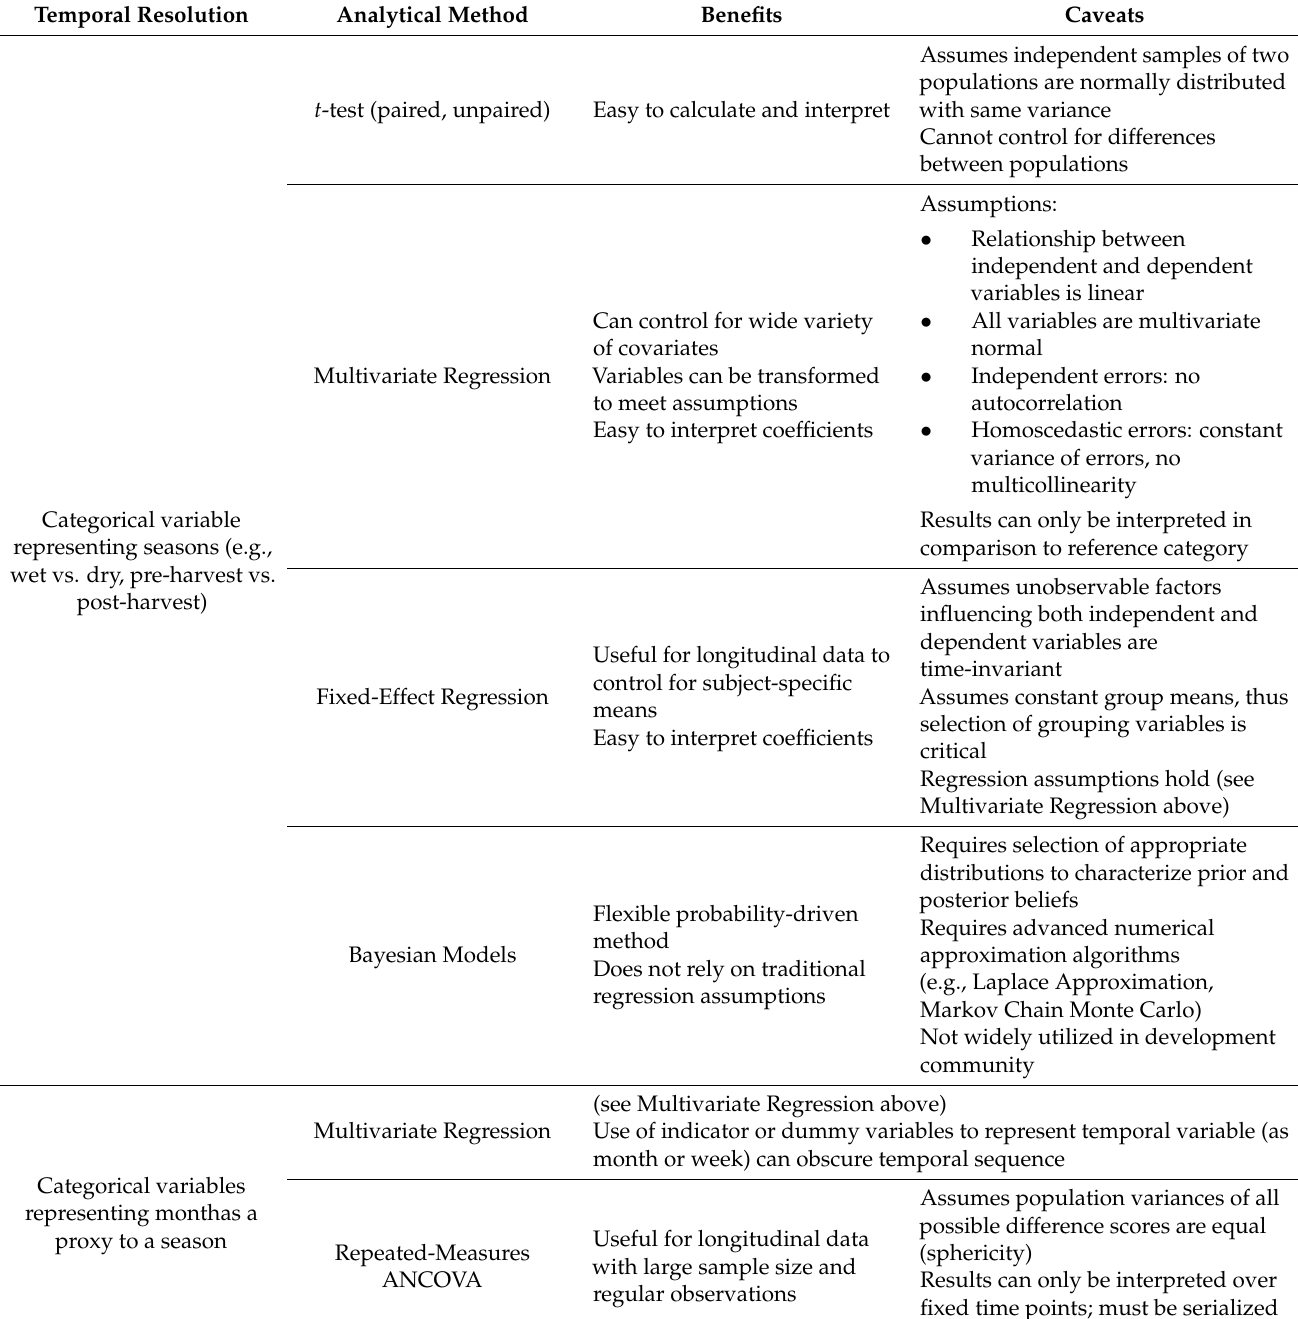
Table 2. Summary of temporal resolution, analytical methods, and their respective benefits and caveats in analyzing nutrition